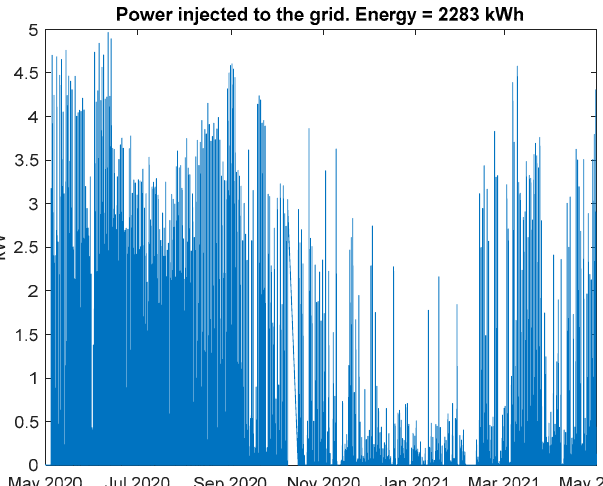
Figure 7. Power injected into the grid throughout the year.